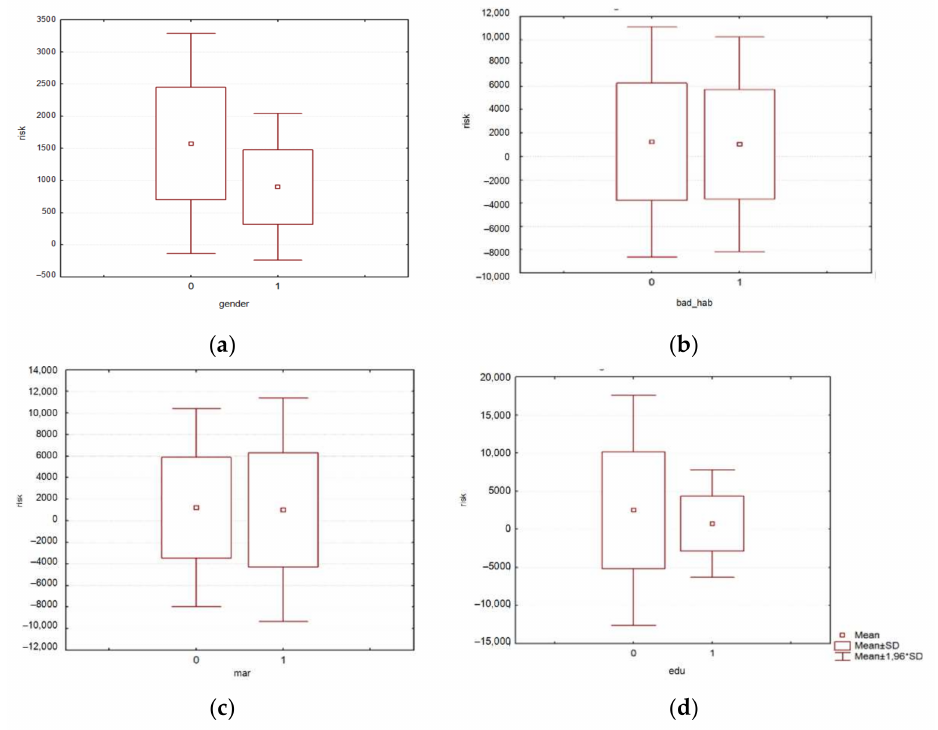
Figure 2. Diagrams about the ranges for factor groups such as gender and risk ( a ), bad_hab and risk ( b ), mar and risk ( c ), and edu and risk ( d